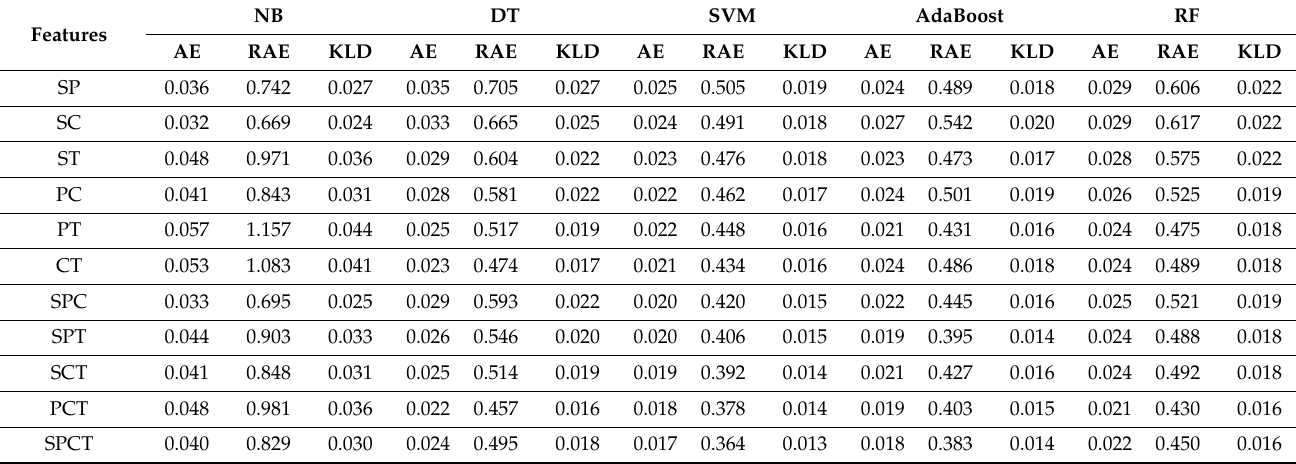
Table 7. Comparison of feature sets combination using ML classifiers on SemEval2017.